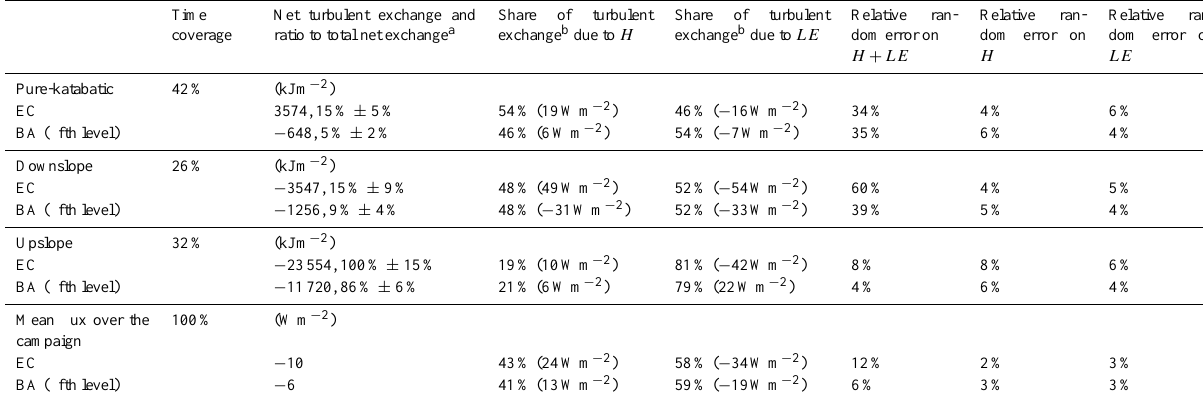
Table 2. Overview of turbulent fluxes and related random errors calculated with the eddy-covariance (EC) method and bulk-aerodynamic (BA) method using the fifth level of the profile ( ∼ 2m height). Time occupied by the subset in the campaign (first column), net turbulent exchange ( H + LE ) for each wind regime and its ratio (%) to total net turbulent exchange of good-quality runs (GQRs) (second column), share of H and LE in the net exchange and mean flux exchange over the GQRs (third and fourth columns). Relative random errors calculated with the Mann and Lenschow (1994) (for EC fluxes) and Monte Carlo (for BA fluxes) methods in individual H and LE fluxes and net turbulent fluxes (fifth to seventh columns). The two last lines show results obtained for all GQRs. Relative ran- Relative ran- Time Net turbulent exchange and Share of turbulent Share of turbulent Relative ran- dom error on coverage ratio to total net exchange a exchange b due to H exchange b due to LE dom error on dom error on H H + LE